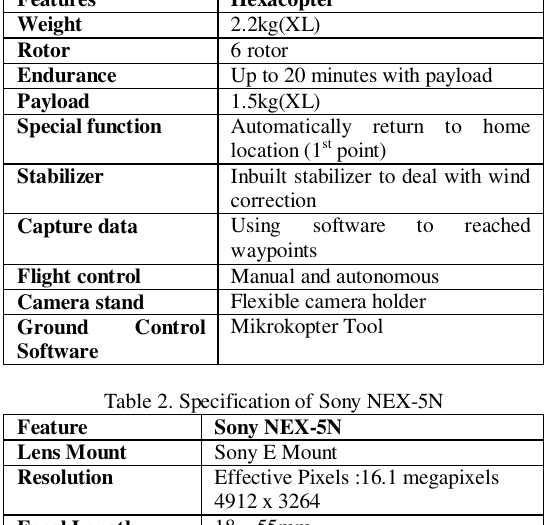
Table 1. Hexacopter Specification (Tahar and Ahmad, 2012)